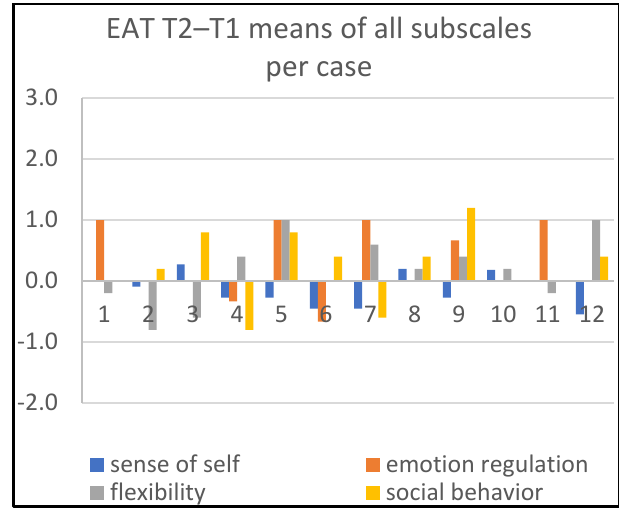
Figure 2. Means of all subscales per case, T2–T1.